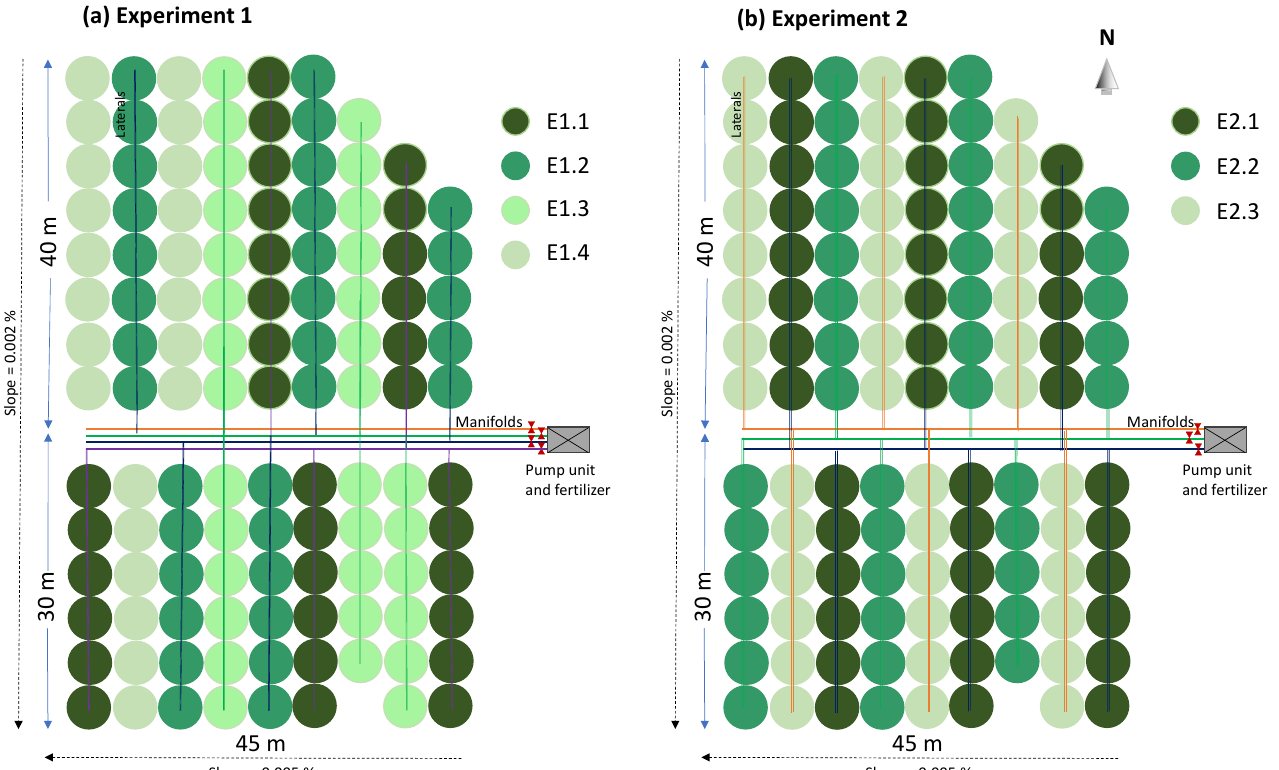
Figure 2. Experimental schemes in experiments ( a ) E1 (2007–2011) and ( b ) E2 (2015–2017). The water was transported from a well to the field by a PVC mainline and distributed to four polyethylene manifold pipes. One lateral supplied each tree row in the plots with pressurized irrigation systems (i.e., drip, bubblers, and mini-sprinklers). Each E1 treatment registered the same net irrigation amount and frequency (Table 4). Irrigation was triggered when soil water contents in the rootzone dropped below 90% of θ FC . Net irrigation amounts were determined based on the measurements of field irrigation efficiency for the studied irrigation method following the guidelines in Merriam and Keller [62], with dripping, bubblers, mini-sprinklers, and ring basins assuming values of 90%, 86%, 84%, and 68%, respectively. Irrigation was performed from mid-April to the end of October and thus out of the rainfall